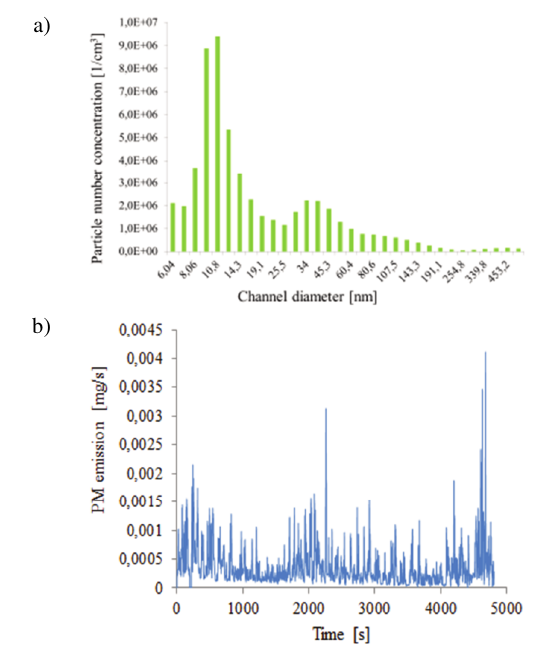
Fig. 6. Solid components of exhaust gases: a) particle number concentra- tion, b) particle mass